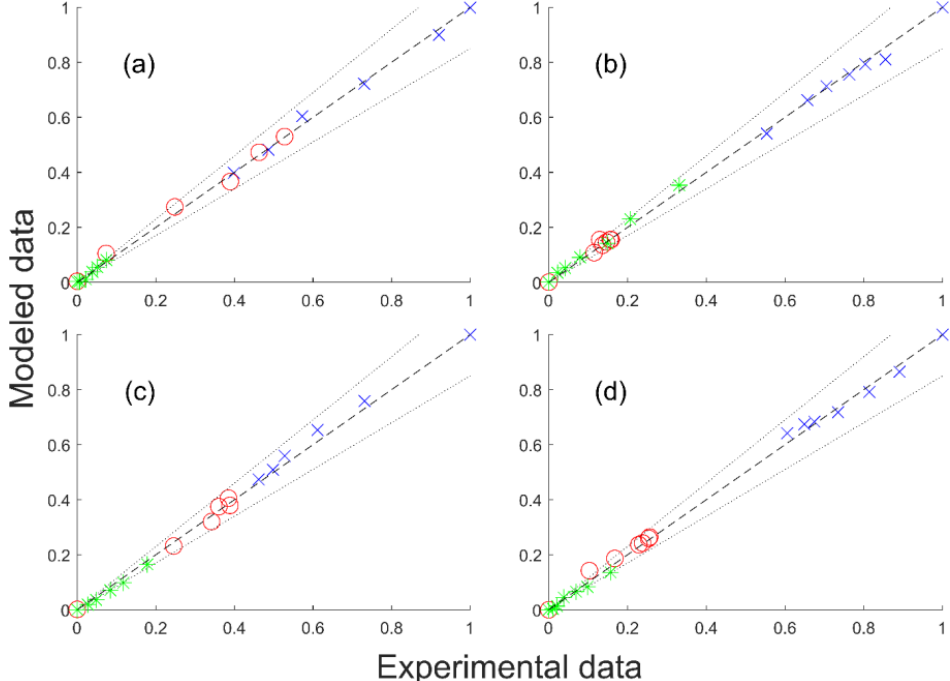
Figure 5. Parity diagram of the extrapolation of Model 3 with the adjusted parameters. GBL (blue times cross), BDO (red circle) and side products (green star). Experimental molar fraction vs. modeled molar fraction: ( a ) 35 bar, 200 °C; ( b ) 25 bar, 240 °C; ( c ) 35 bar, 220 °C; ( d ) 25 bar, 220 °C. Dotted lines represent ± 15% deviations.